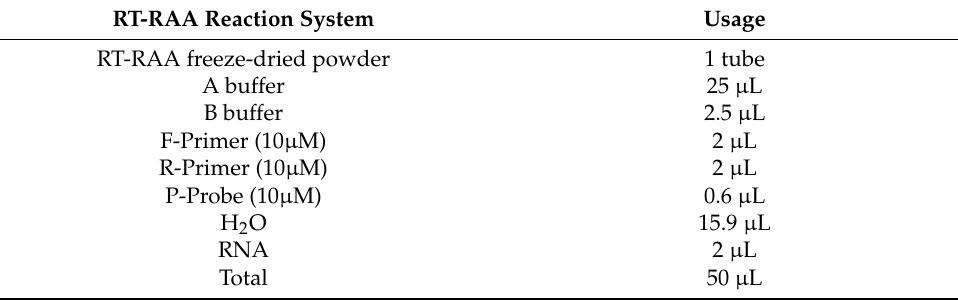
Table 2. The real-time RT-RAA reaction system preparation table. RT-RAA Reaction System